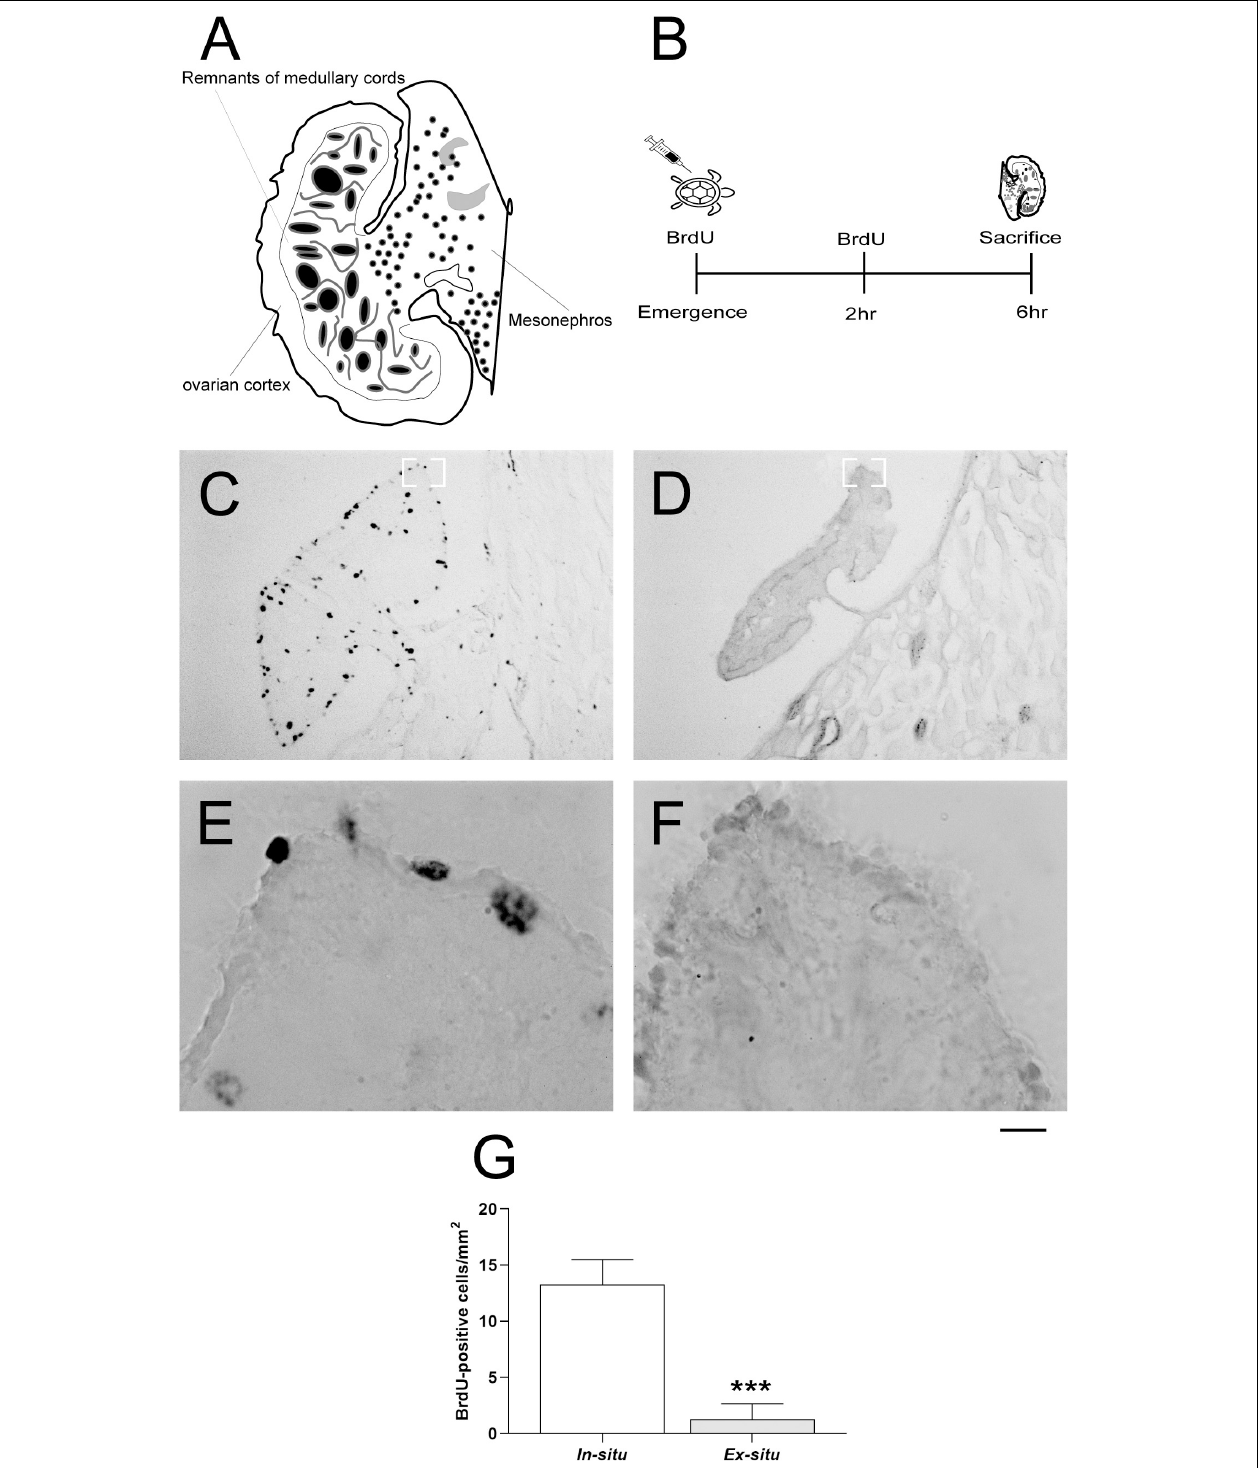
FIGURE 5 | Ovarian cell proliferation in L. olivacea females. (A) Schematic drawing of the turtle gonad-mesonephros complex. (B) Timeline for ovarian cell proliferation analysis. (C,D) Representative ovarian sections showing 5 (cid:48) -bromo-2 (cid:48) -deoxyuridine (BrdU) + nuclei in one turtle from each condition ( in situ and ex situ , respectively). (E,F) Representative high magnification photographs showing BrdU + nuclei in the ovarian cortex of one turtle from each condition ( in situ and ex situ , respectively). (G) Graph showing the density of ovarian BrdU + nuclei. In situ ( n = 5), ex situ ( n = 5). Mean ± SD, Type III Analysis of Variance *** p ≤ 0.001, scale bar = 200 µ m for panels (C,D) and 50 µ m for panels (E,F) .